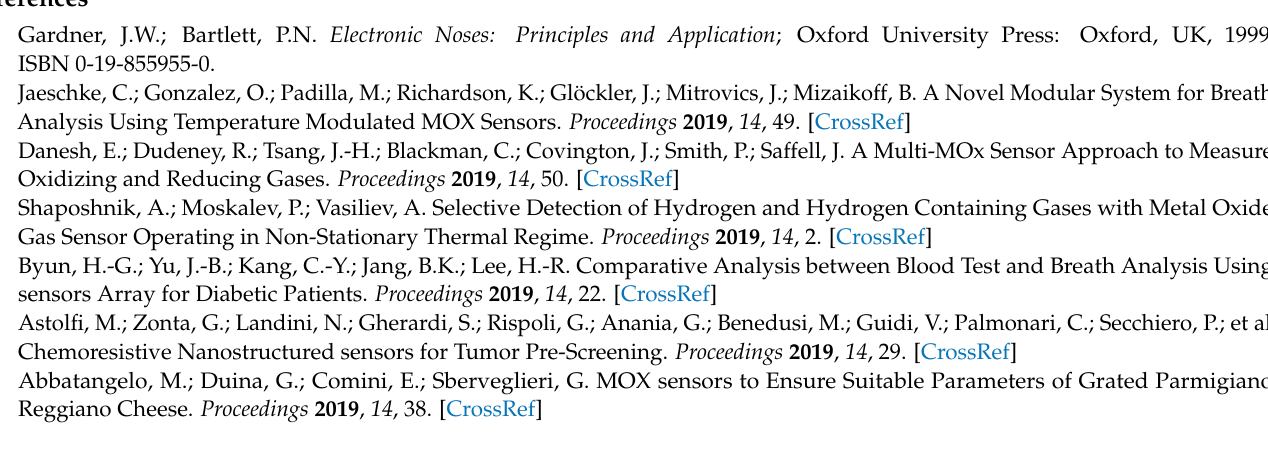
Figure A7. Same as in Figure A6 but with excess holes taking the roles of bond-breaking charges. In this case pairs of positively charged dangling bond defects are formed which are separated and stabilized via H-diffusion.